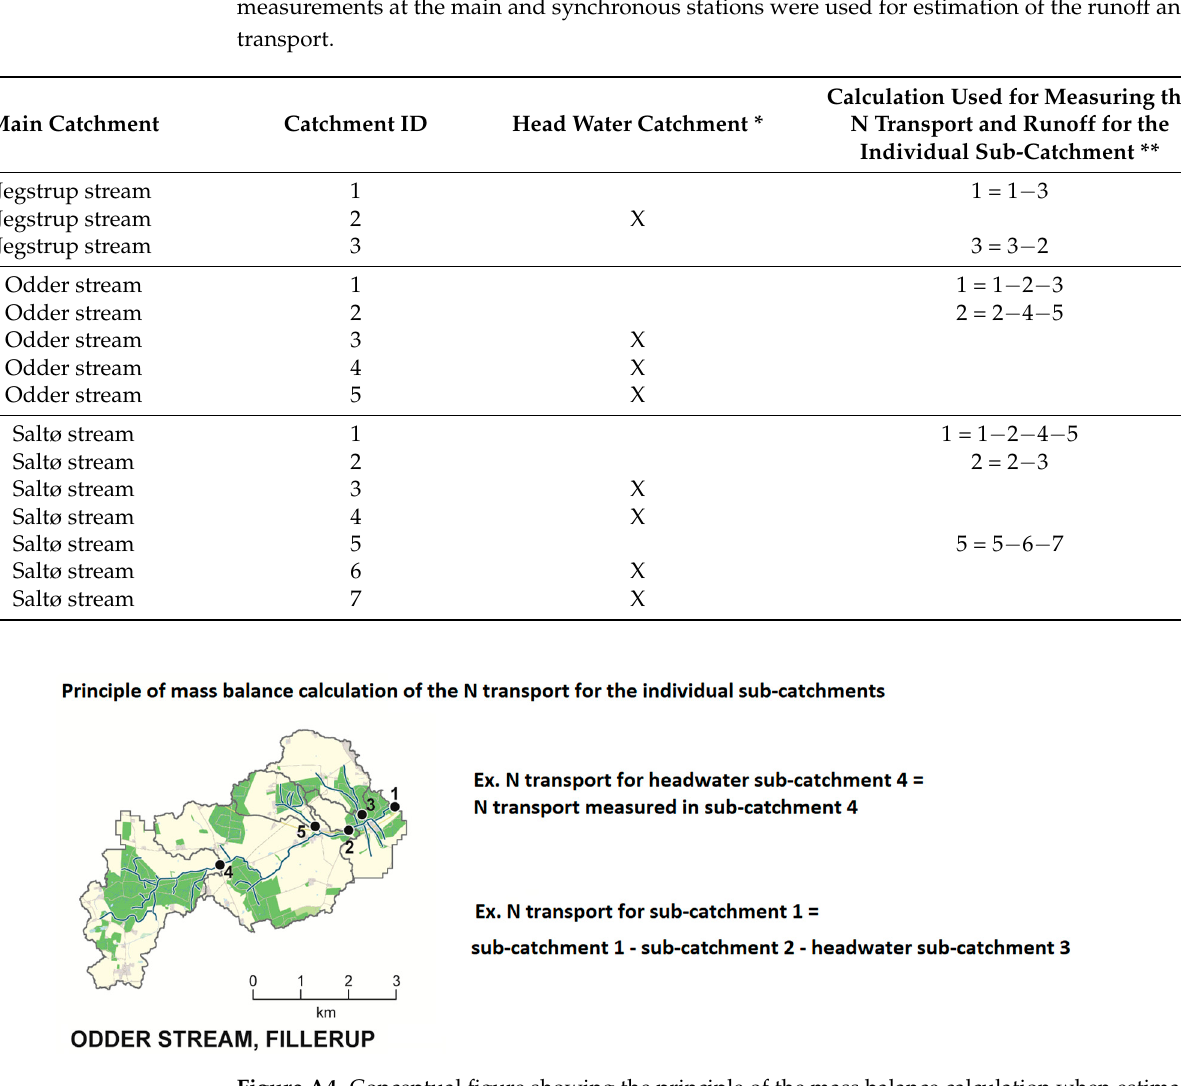
Figure A4. Conceptual figure showing the principle of the mass balance calculation when estimating the runoff and N transport for the individual sub-catchments (1 to 5) in the Odder catchment.